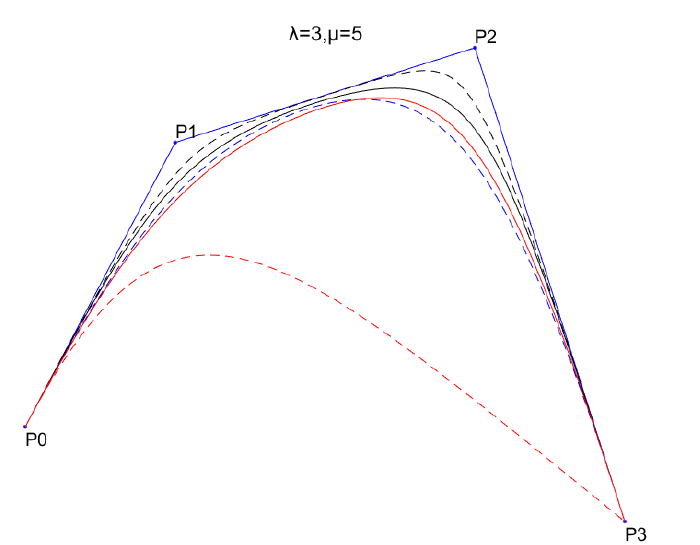
Figure 6. Comparisons among generalized quasi cubic trigonometric Bézier curves (blue dashed lines with α ( t ) and β ( t ) given in Equation (6), black solid lines with α ( t ) and β ( t ) given in Equation (7) and black dashed lines with α ( t ) and β ( t ) given in Equation (8)), λµ –Bézier curves (red solid lines) defined by the λµ –Bernstein basis functions in [7] and classical cubic rational Bézier curves (red dashed lines), where λ = 3, µ =